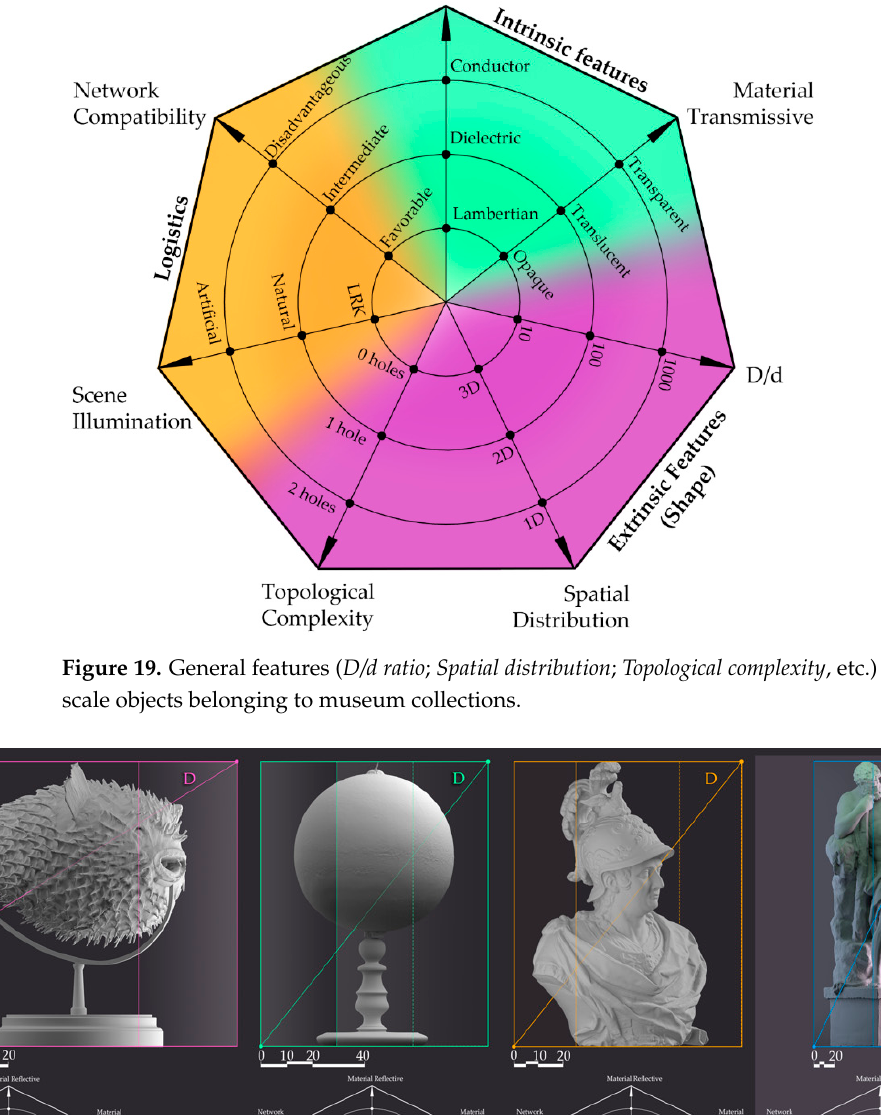
Figure 21. Comparison of our denoise solution ( a) with the original BM3D ( b ) and the image not denoised ( c ). 6.2. Devices, Equipment Used and Acquisition Setup Besides hardware (camera, lights, tripods, rotating table) and software described in Section 2, the evaluation of the shape complexity and geometric accuracy of 3D models obtained by smartphone was carried out adopting the following equipment: A.